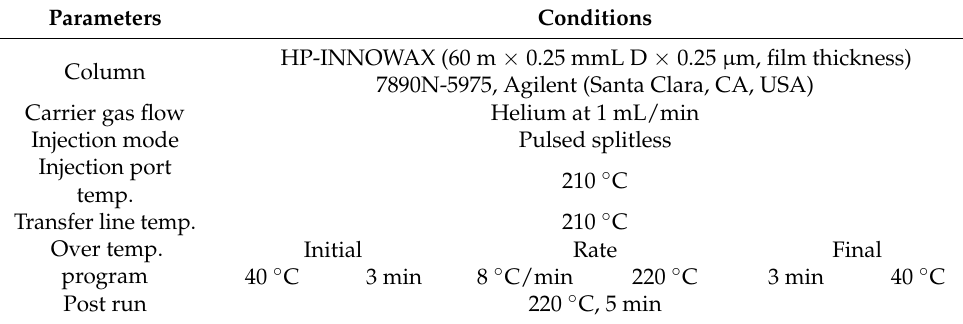
Table 2. The conditions for the operating parameters for